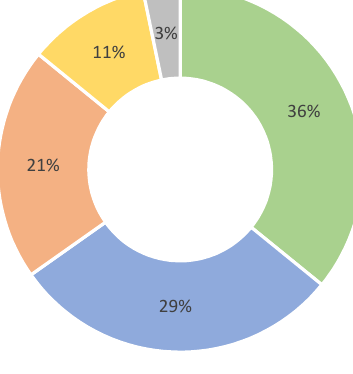
Figure 7. The number and percentage of studies in which sampling frequency was used in specific frequency ranges. This information was not reported in 37% of all papers reviewed. Table 4. Wearable sensor placement on the user’s body or equipment. Papers with sensors that are not wearable are not included in the list. Sensors Location